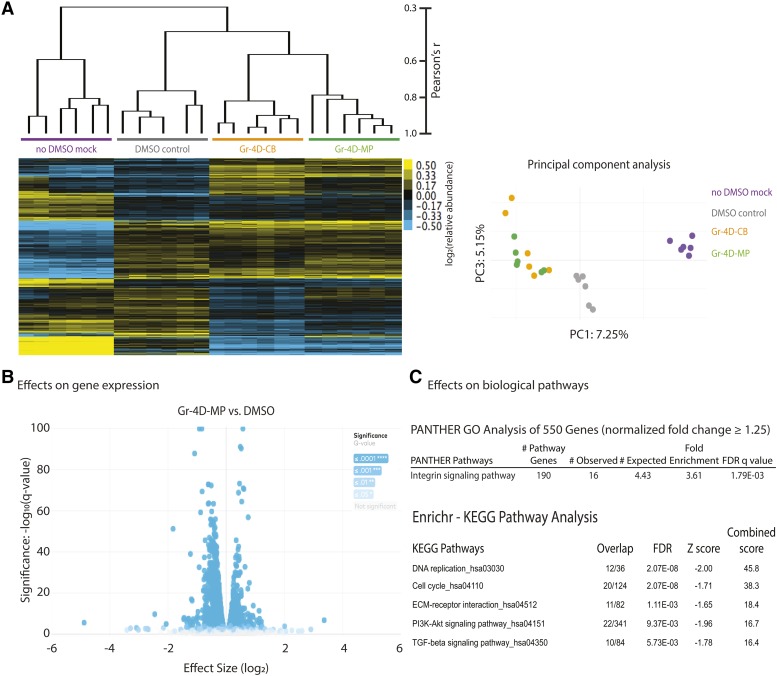
Effects of Gr-4D on gene expression of WI-38 cells. A) Pearson’s correlation between global transcriptional profiles for cells treated with Gr-4D. Shown are the normalized gene expression matrices (transcripts per million, TPM values) of the 8,000 genes detected in every RNA-seq sample, grouped by unsupervised clustering using Pearson correlation coefficient as a distance metric. Note that most DMSO (0.1%) controls were clustered together on the tree, as were the no-DMSO mock controls or samples treated with Gr-4D (2.5 μM) from two different vendors (CB, ChemBridge; MP, MolPort). This correlation was observed also in the principal component analysis (PCA), by projecting two major components (PC1 and PC3), which explained 7.25% and 5.15% variation of global gene expression, respectively. B) Volcano plot showing effects of Gr-4D on gene expression. Shown are the normalized expression level (X axis) and FDR-adjusted significance (Y axis) for one Gr-4D (from MolPort). Each dot represents a gene that was differentially expressed in WI-38 cells upon treatment with Gr-4D (see Supplemental Table 5). C) Pathway analysis indicating effects of Gr-4D on certain pathways. Shown are the top pathways affected (by PANTHER analysis of 550 significant genes, with FDR-adjust q value of overlap with the known pathway genes < 0.05; or by Enrichr-KEGG pathway analysis, with a ranking score combining both FDR and z score > 10) (see Supplemental Table 6A).